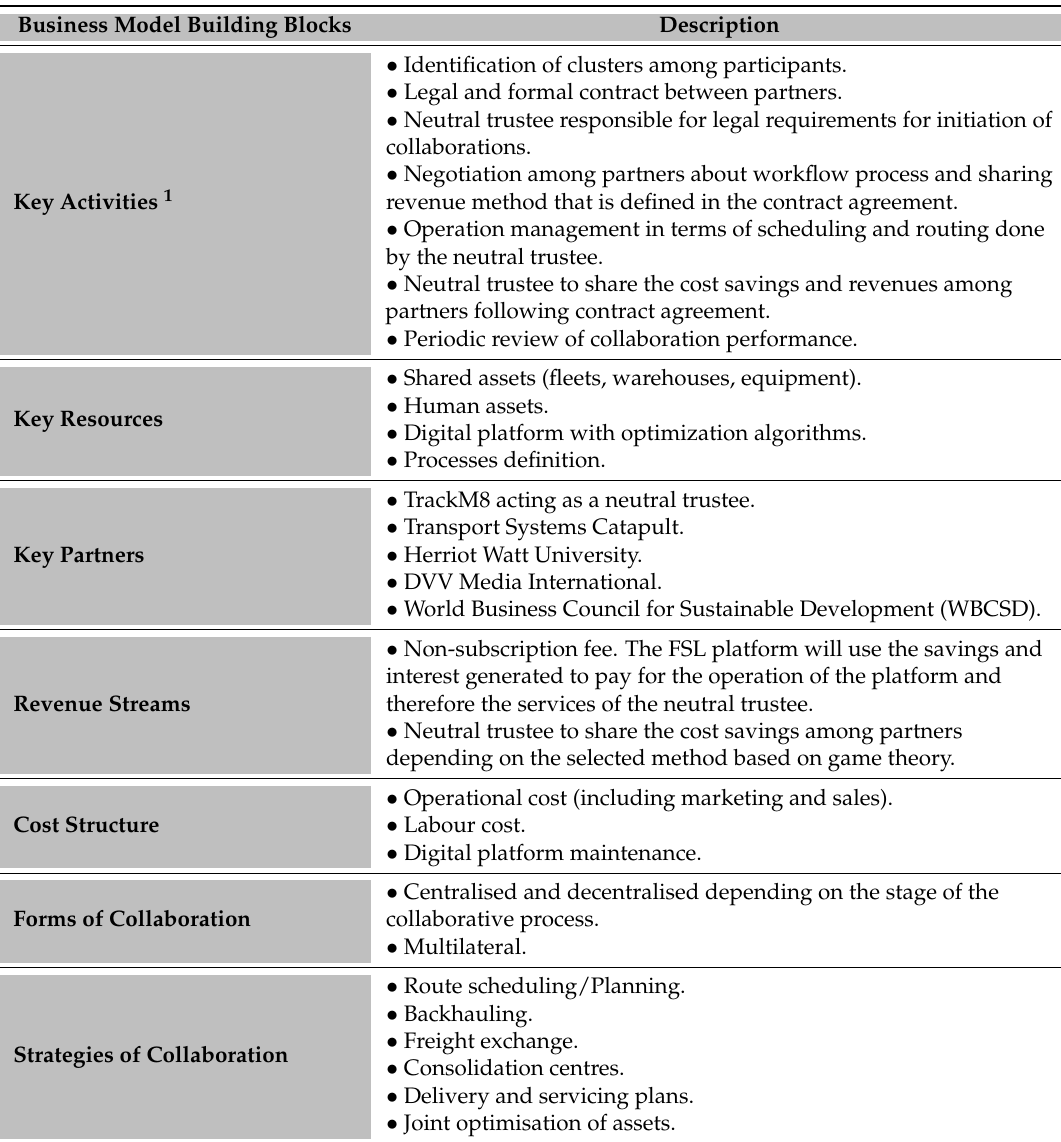
Figure 11, reflects Stages 1, 2 and 3 of the collaboration. Figure 12, represents Stage 4 of the collaboration